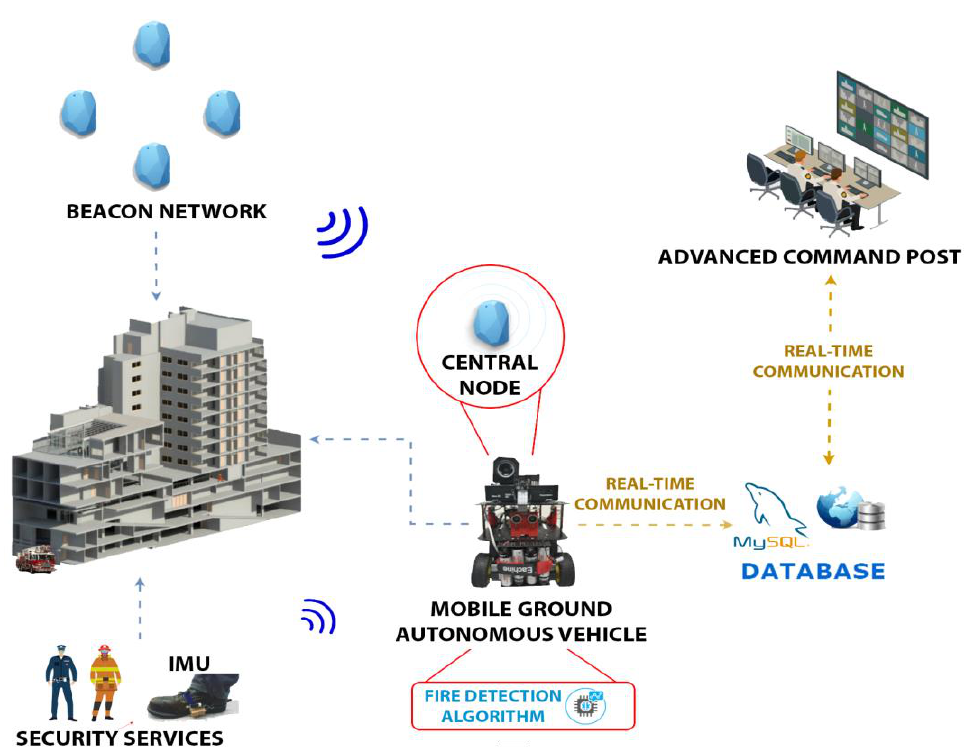
Figure 1. Diagram of the proposed monitoring system for indoor first-responder interventions 245